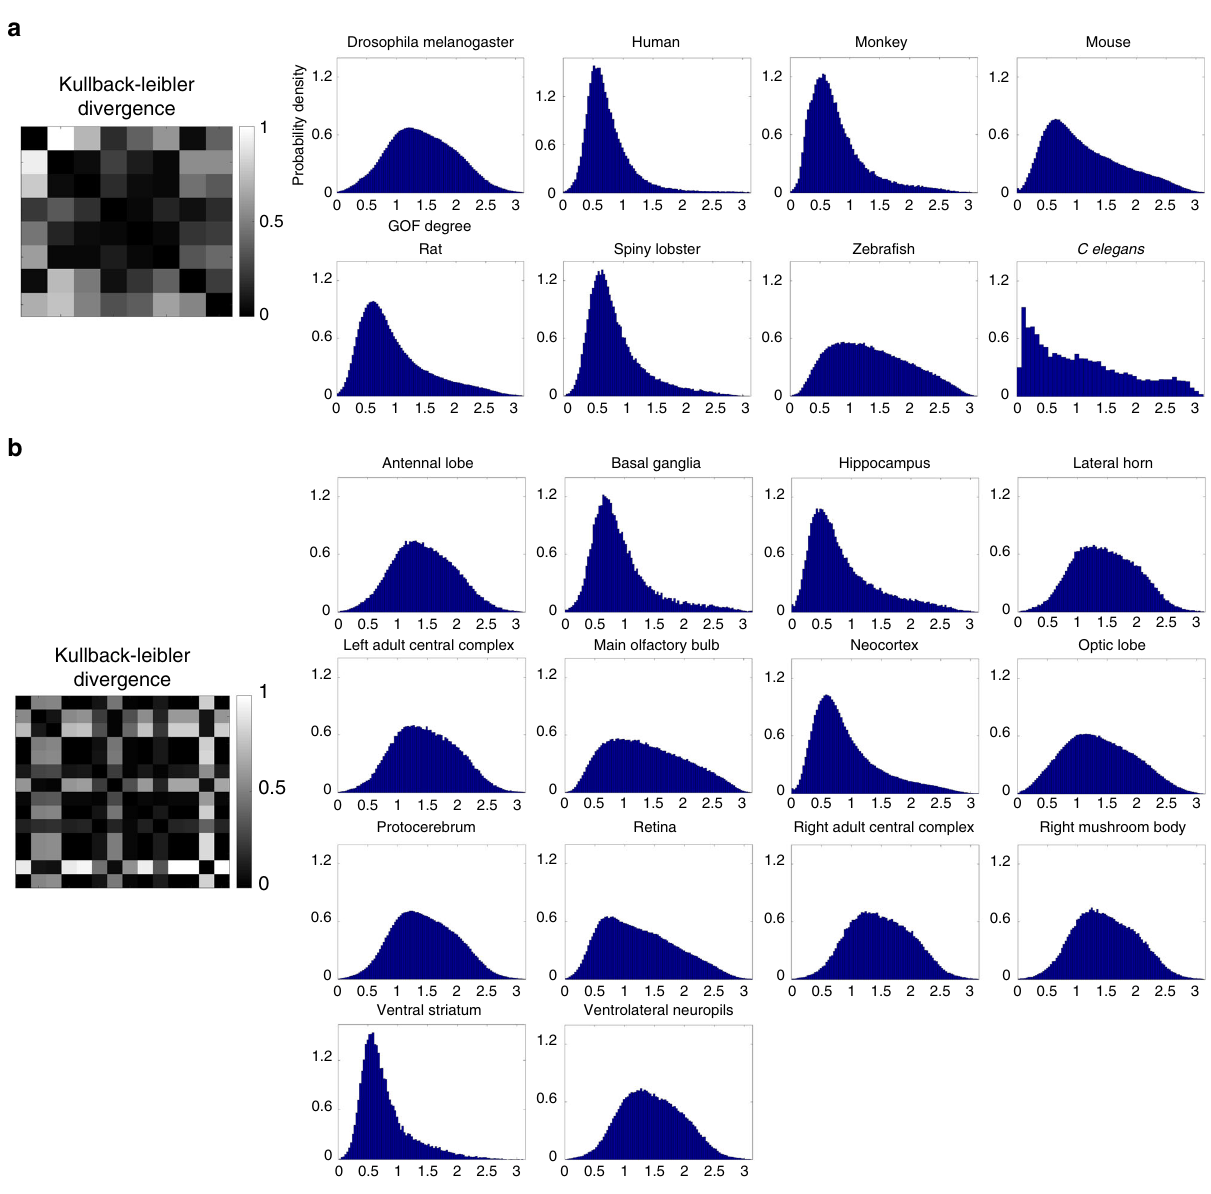
Fig. 3 GOF distributions obtained from public datasets available on the NeuroMorpho.Org website. Neurons are cataloged by species or by brain regions. a GOF distribution of each species contains more than one thousand neurons (excluding C. elegans which only has 424 neurons in total). b GOF distribution of each brain region contains more than one thousand neurons. Kullback-Leibler divergence was performed on different species and different brain regions,